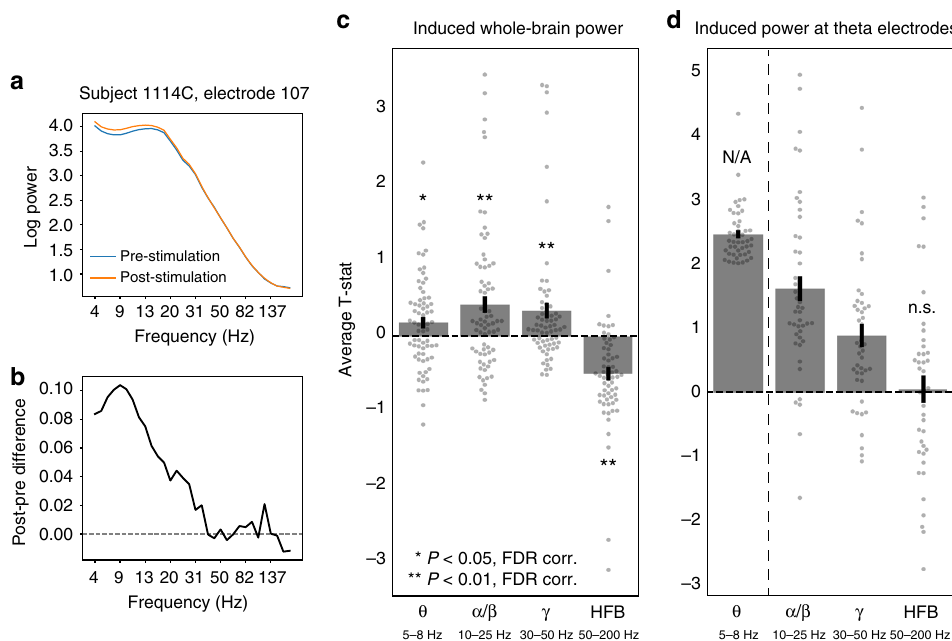
Fig. 6 Stimulation-induced power across frequency bands. a Stimulation-induced power spectrogram for an example electrode from a single subject (stimulation in left MTL white matter, recording electrode in left inferior parietal cortex). b Post- minus pre-stimulation difference in power from the electrode in a . c Whole-brain stimulation-induced power was measured by computing a t -statistic on the pre- vs. post-stimulation spectral power at each electrode in a subject, and then averaging across electrodes to get an estimate of whole-brain change in power. On average, stimulation elevated whole- brain power in the theta (5 – 8 Hz), alpha/beta (10 – 25 Hz), and gamma (30 – 50 Hz) bands (one-sample t -test, FDR-corrected P < 0.05). Stimulation decreased power in the HFB range (50 – 200 Hz). d For each subject/stimulation site, electrodes were classi fi ed by whether they exhibited a signi fi cant ( t > 2) change in theta power induced by stimulation (at least 1 theta-responsive electrode was found for 47 of the 72 stimulation sites). The stimulation- induced change at higher frequencies was computed for this subset of electrodes, to determine whether the power response was speci fi c to theta. Across all subjects/stimulation sites, increased power was observed in the alpha/beta and gamma range at theta-responsive electrodes, but no effect was observed in the HFB range (one-sample t -test, t (46) = 0.25). The bar for induced theta power is delineated by a dashed line and shown as a reference only, since theta power was the basis for selecting these electrodes for further analysis. Error bars show ±1 SEM; *corr. P < 0.05; **corr. P <